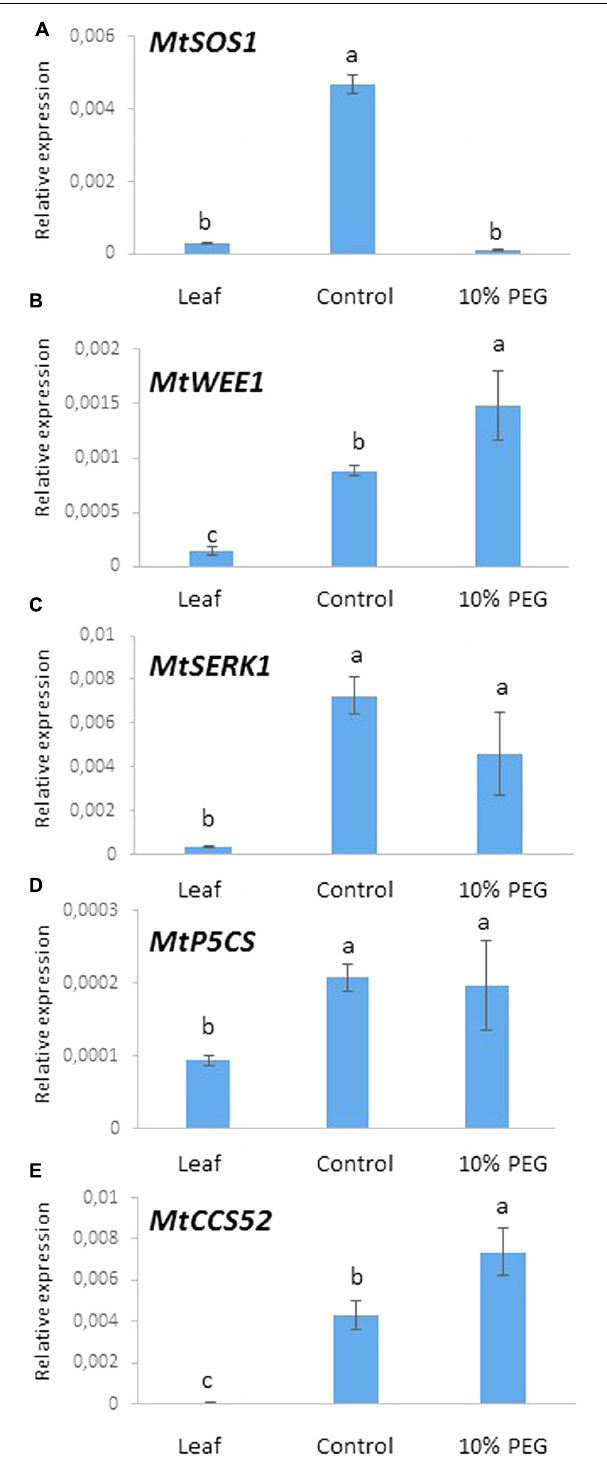
FIGURE 6 | Gene expression after 6 months culture on 10% PEG medium and control (MANA medium) with leaf as reference: (A) MtSOS1 , (B) MtWEE1 , (C) MtSERK , (D) MtP5CS, and (E) MtCCS52 . Different letters indicate significant differences amongst treatments/tissues ( P ≤ 0.05; one-way ANOVA; n = 3 ±